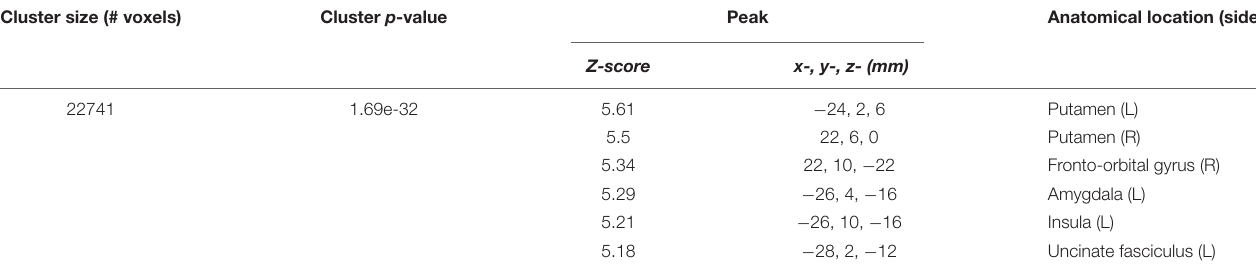
TABLE 3 | Summary of primary fMRI activation clusters associated with performance during the practice blocks (Performance-specific task activity). Cluster size (#